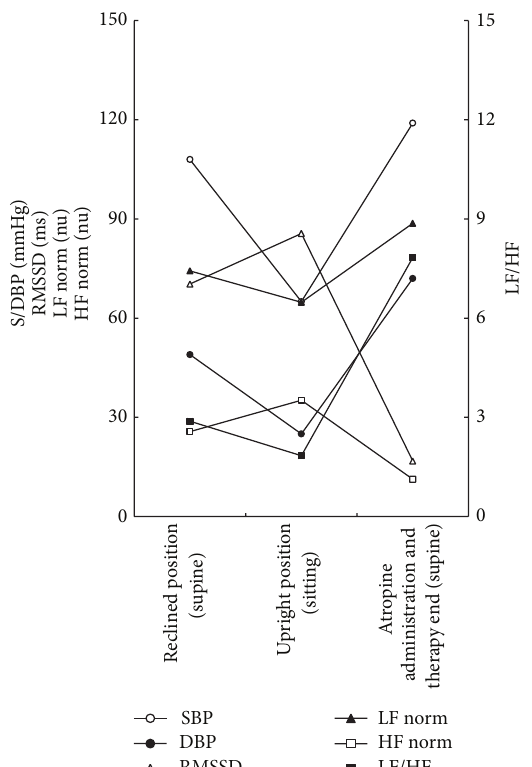
Figure 1: Time course of S/DBP and frequency-/time-domain HRV variables with postural